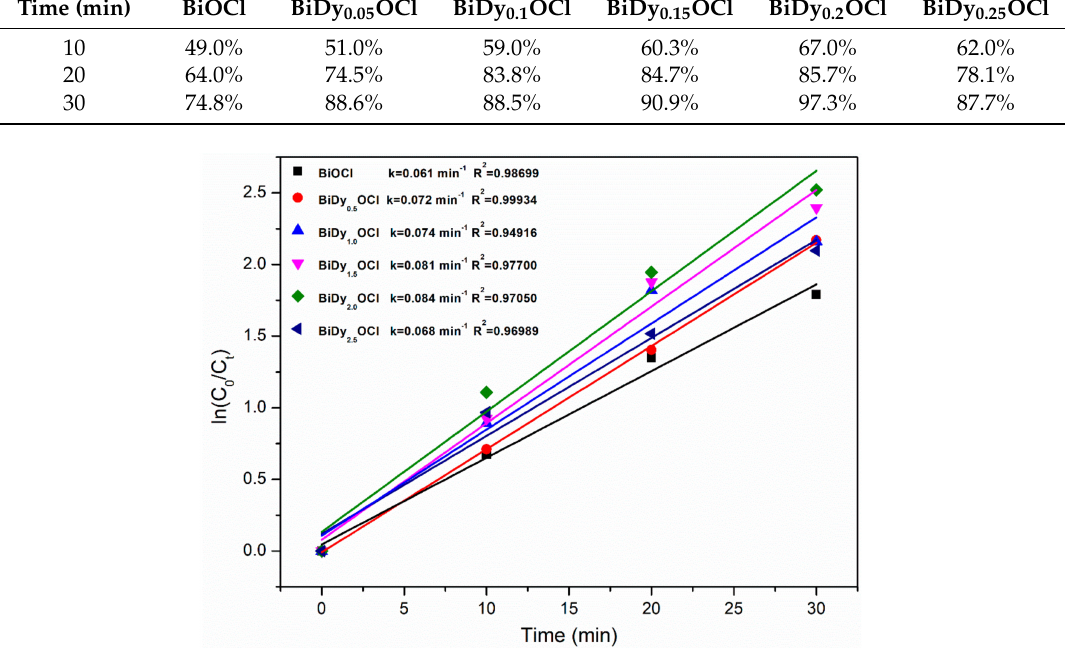
Figure 10. Kinetic linear fitting curve for RhB degradation using different photocatalyst